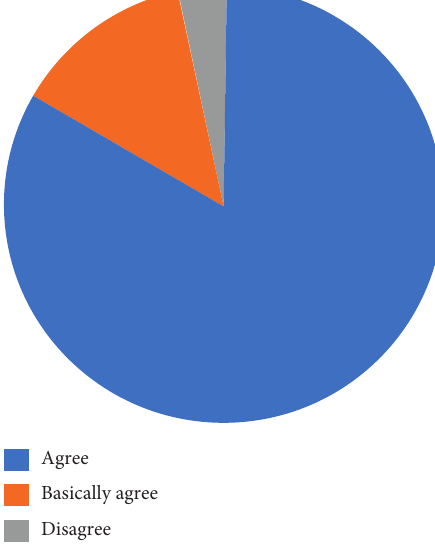
Figure 3: Results of the second questionnaire survey.